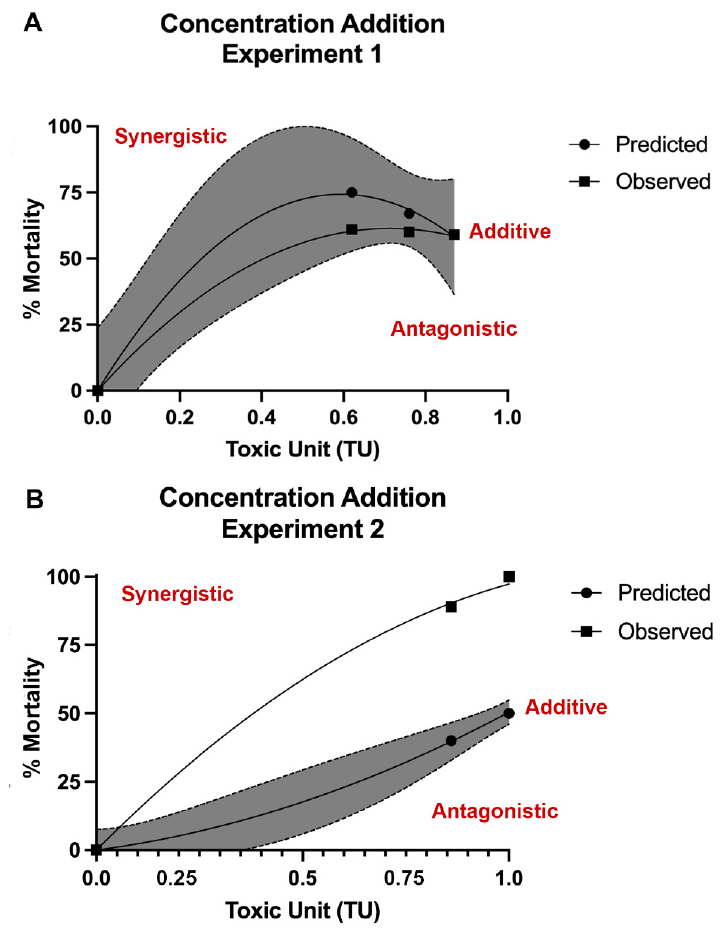
Figure 6. Observed and predicted mortality using the concentration addition (CA) model. De- veloping zebrafish were exposed to the metal mixtures from 1 to 120 h post fertilization (hpf) and mortality recorded. Results were compared to predicted mortality based on CA models when the Pb LC 25 (39.0 ppm, mg/L) concentration was held constant ( A ) or when the Pb LC 50 (73.76 ppm) concentration was held constant ( B ). Similarity of predicted and observed curves indicates additive interaction (within in shaded region) ( A ), where upper deviation from predicted curve suggests synergistic response ( B ). N = 3 biological replicates per treatment group with 50 subsamples per biological replicate.